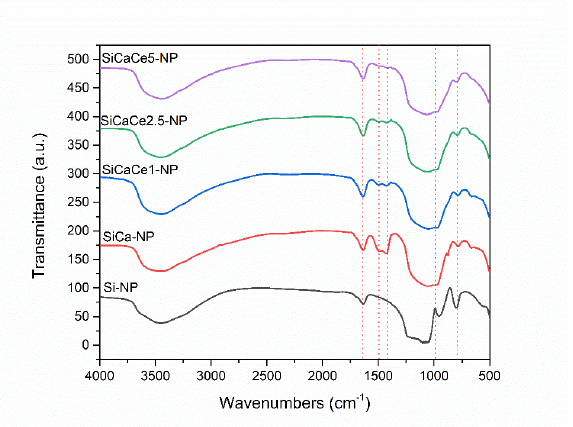
Figure 2. FT-IR spectra of NPs.